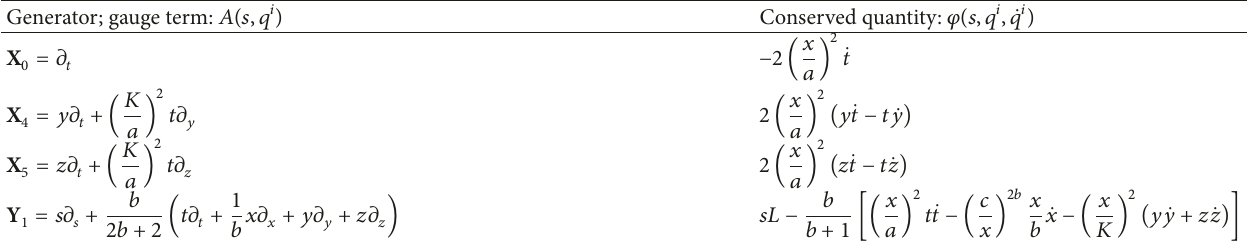
Table 25: Conserved quantities corresponding to each Noether symmetry.